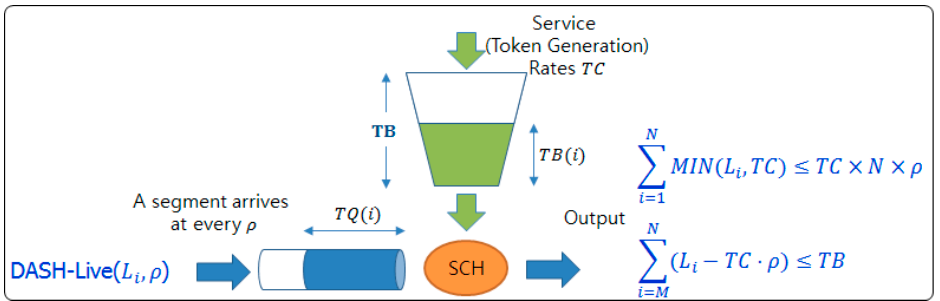
Figure 3. Time-bound token bucket traffic model.